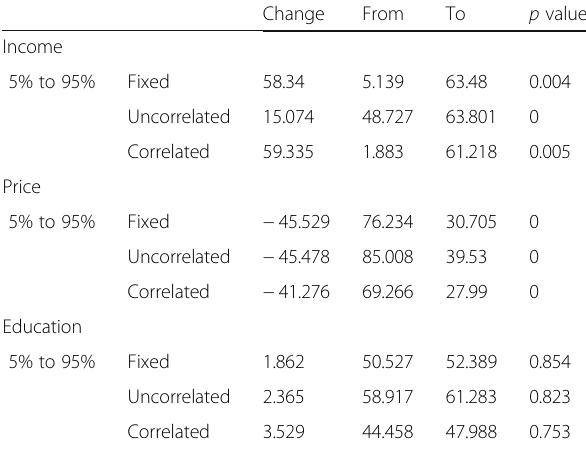
Table 10 Starting and ending probabilities of the discrete changes for the continuous independent variables (income, price, and education) across the three models